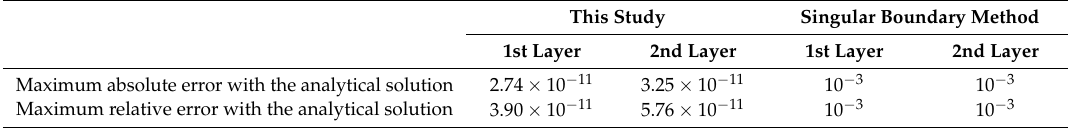
Figure 14. Accuracy of the proposed method (with the comparison of the analytical solution). ( a ) Absolute error in the first layer, ( b ) absolute error in the second layer, ( c ) relative error in the first layer, and ( d ) relative error in the second layer. Table 1. Comparison of computed results with those from references.